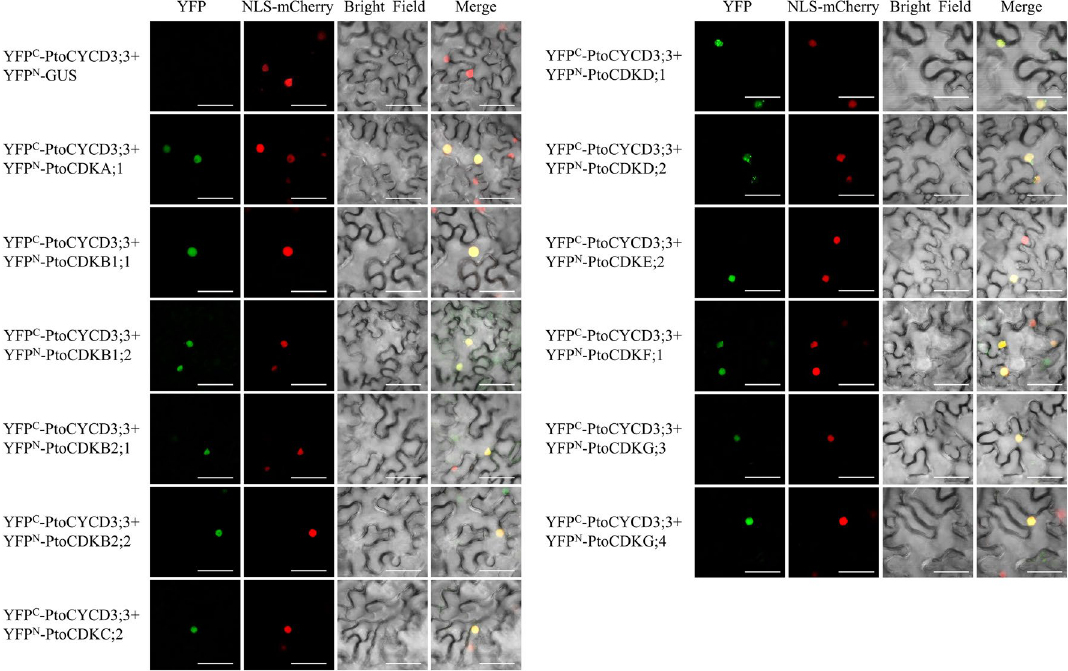
Figure 6. BiFC validation in tobacco epidermis. PtoCYCD3;3 connects pSPYCE(MR) vector and PtoCDKs connects pSPYNE(R)173 vector. After co-expression in tobacco leaf epidermal cells, the fluorescence signal was observed under a laser confocal microscope. YFP C -PtoCYCD3;3 + YFP N -GUS were used as negative control. YFP: yellow fluorescent signal; NLS-mCherry: nuclear signal localisation label; Bright field: brightfield vision; Merge: superposition of fluorescence signals, bar = 50